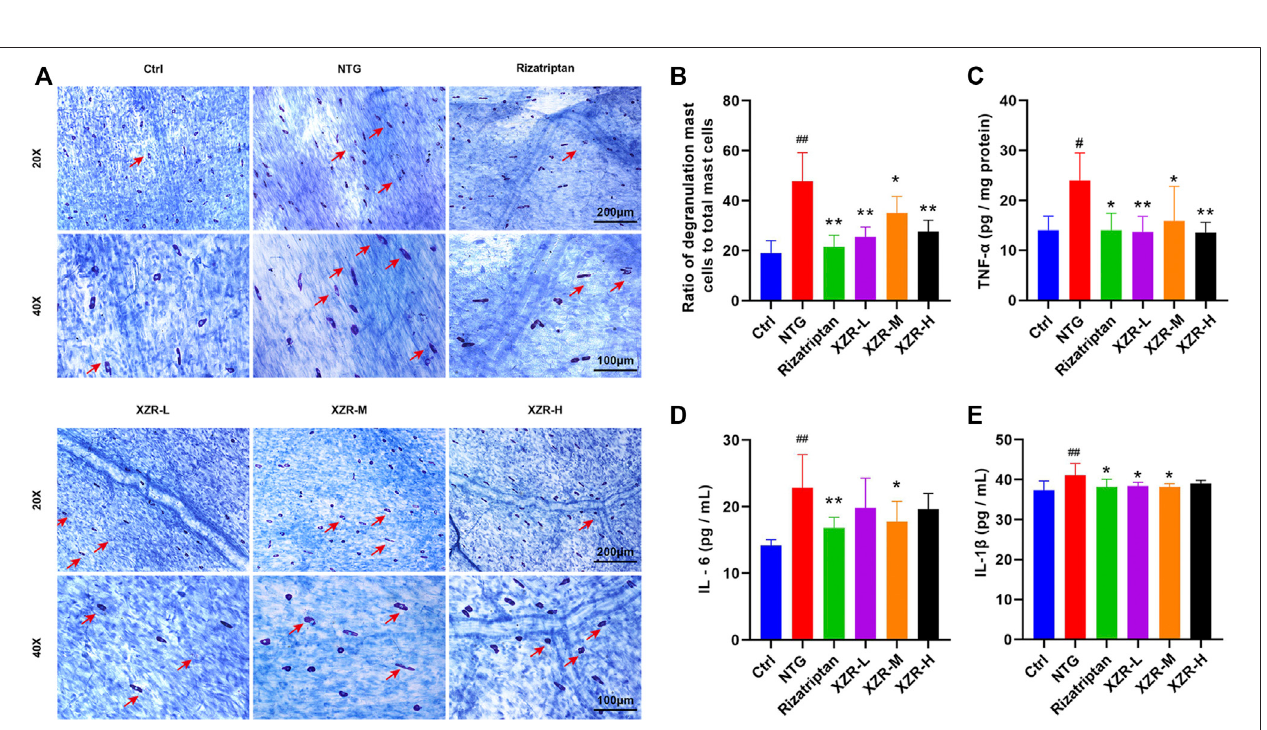
Frontiers in Pharmacology |